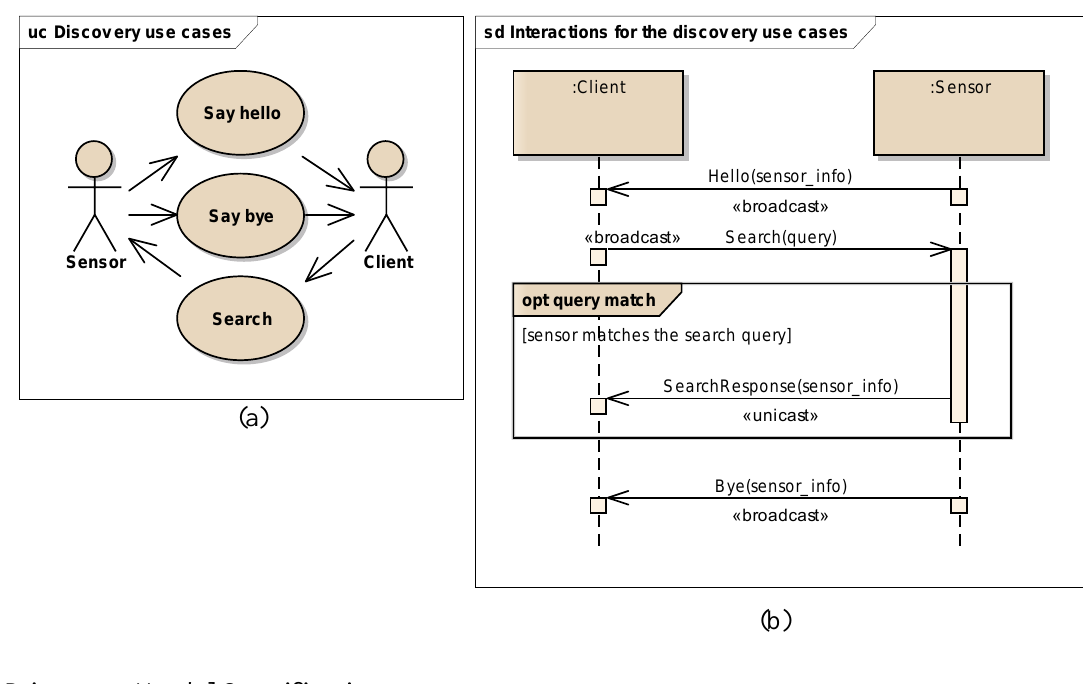
Figure 1. Discovery use cases ( a ) and behavior ( b